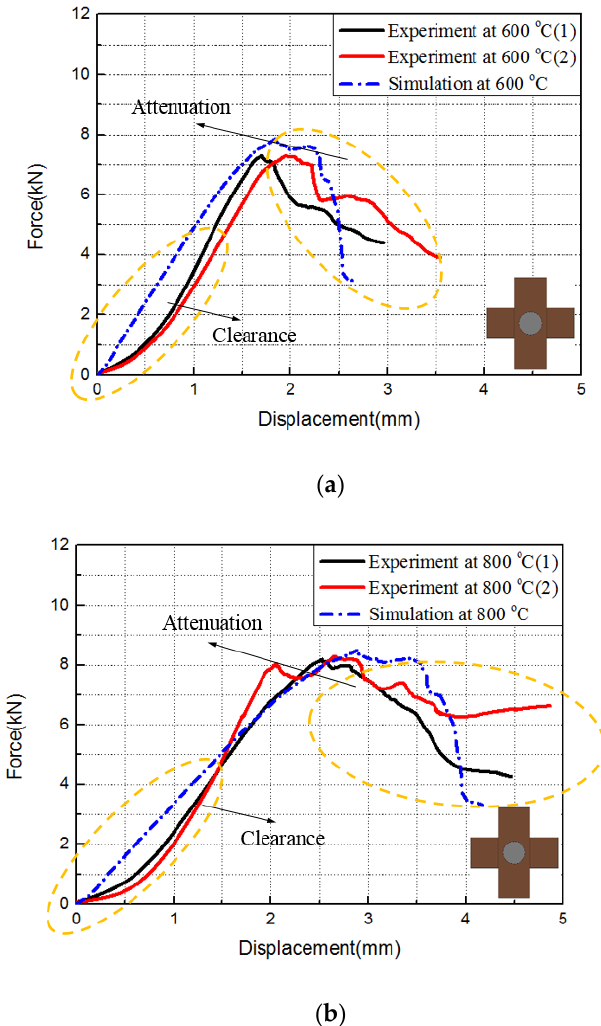
Figure 15. Force–displacement curves of the countersunk bolt joints at ( a ) 600 °C and ( b ) 800 °C .